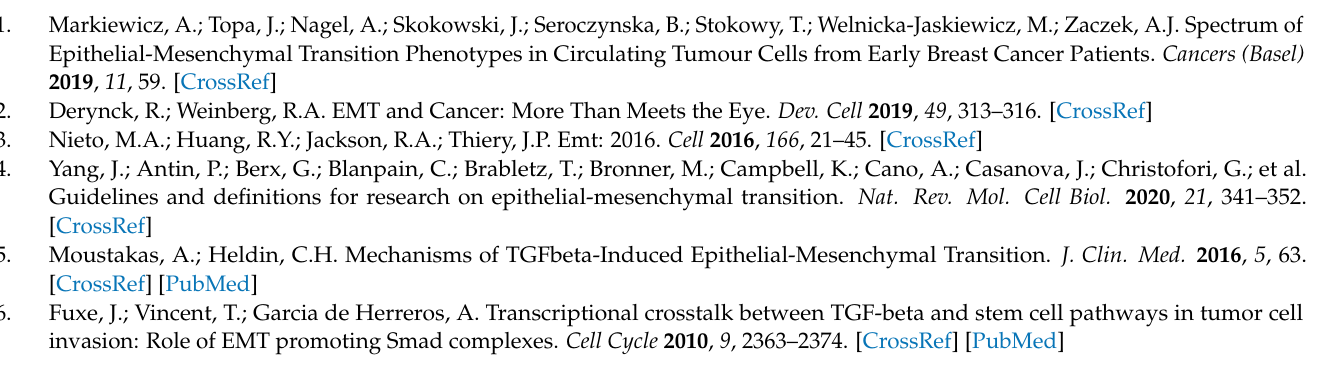
origin, Figure S2: Effect of SDC1 knockdown on EMT markers in A549 cells, Figure S3: Effect of SDC1 overexpression on EMT markers in B6FS fibrosarcoma